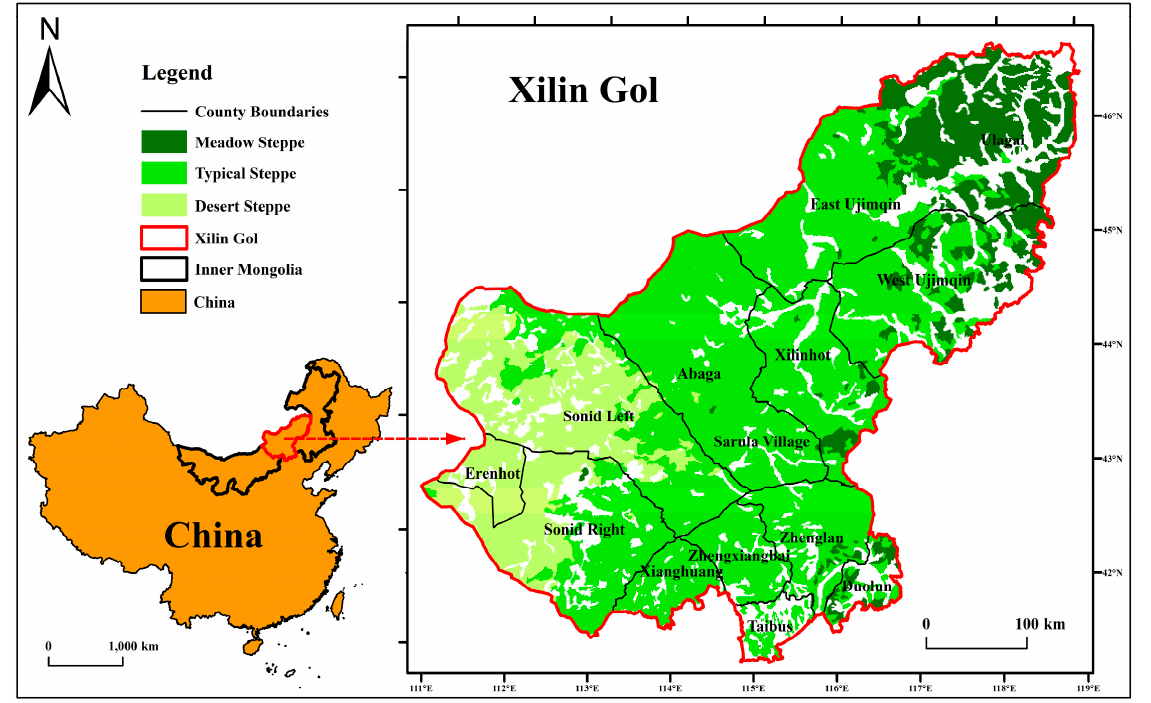
Figure 1. The grassland in Xilin Gol .